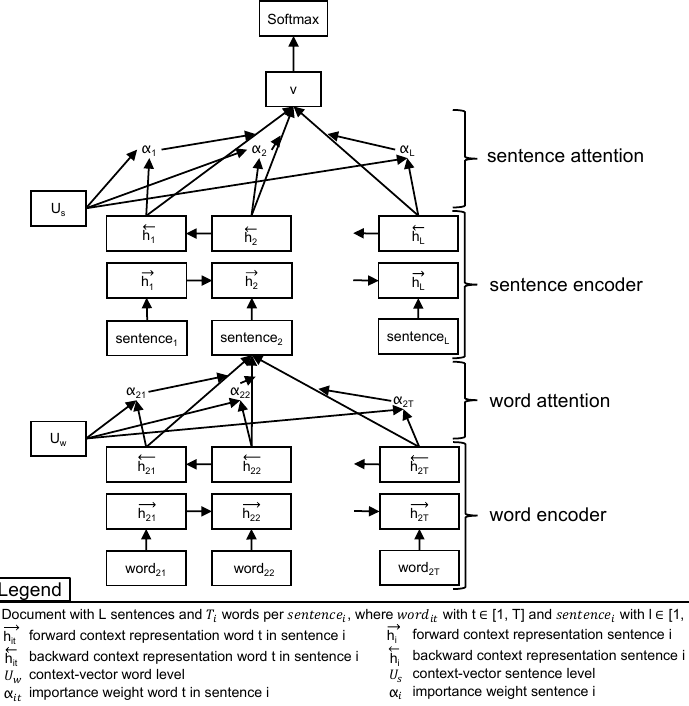
Figure 1. Architecture HAN cf.